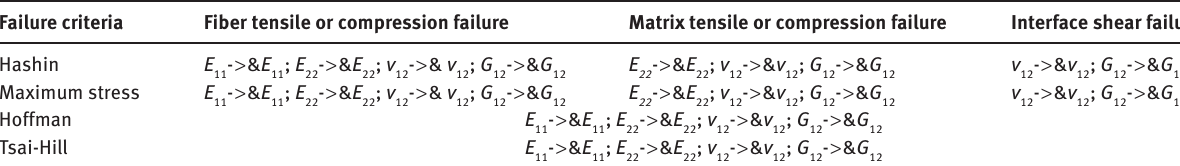
Table 4: Material elastic properties degradation scheme for instantaneous damage.